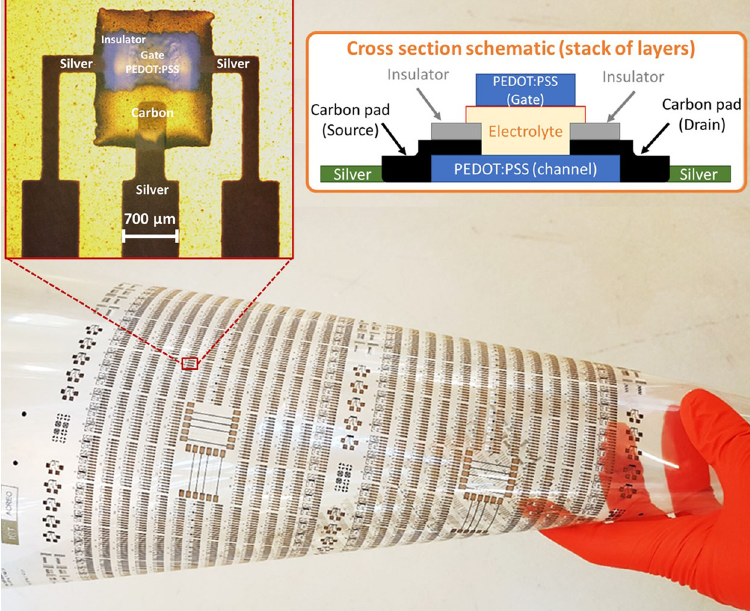
Fig. 1 Screen-printed OECTs. A screen-printed sheet containing 760 OECTs, a microscope image of a single OECT, and a cross-section schematic illustrating the different material layers of the OECT